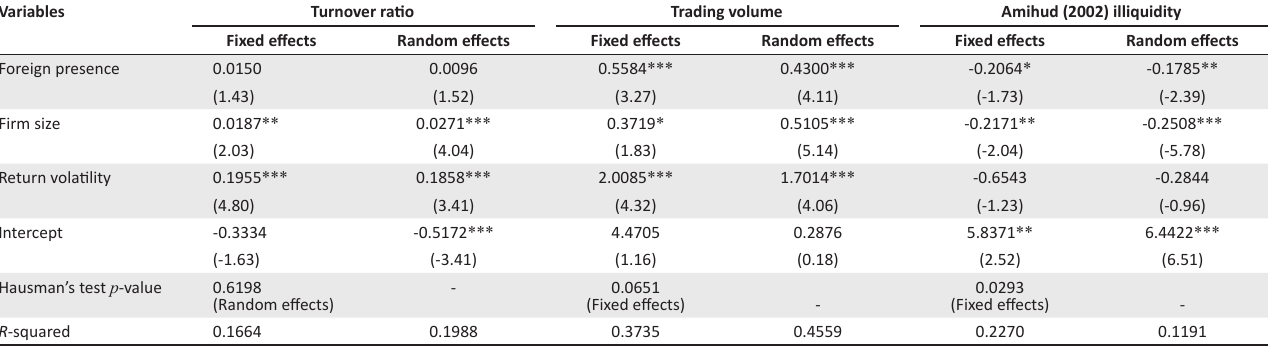
TABLE 3: Liquidity changes around event date – Unmatched sample.